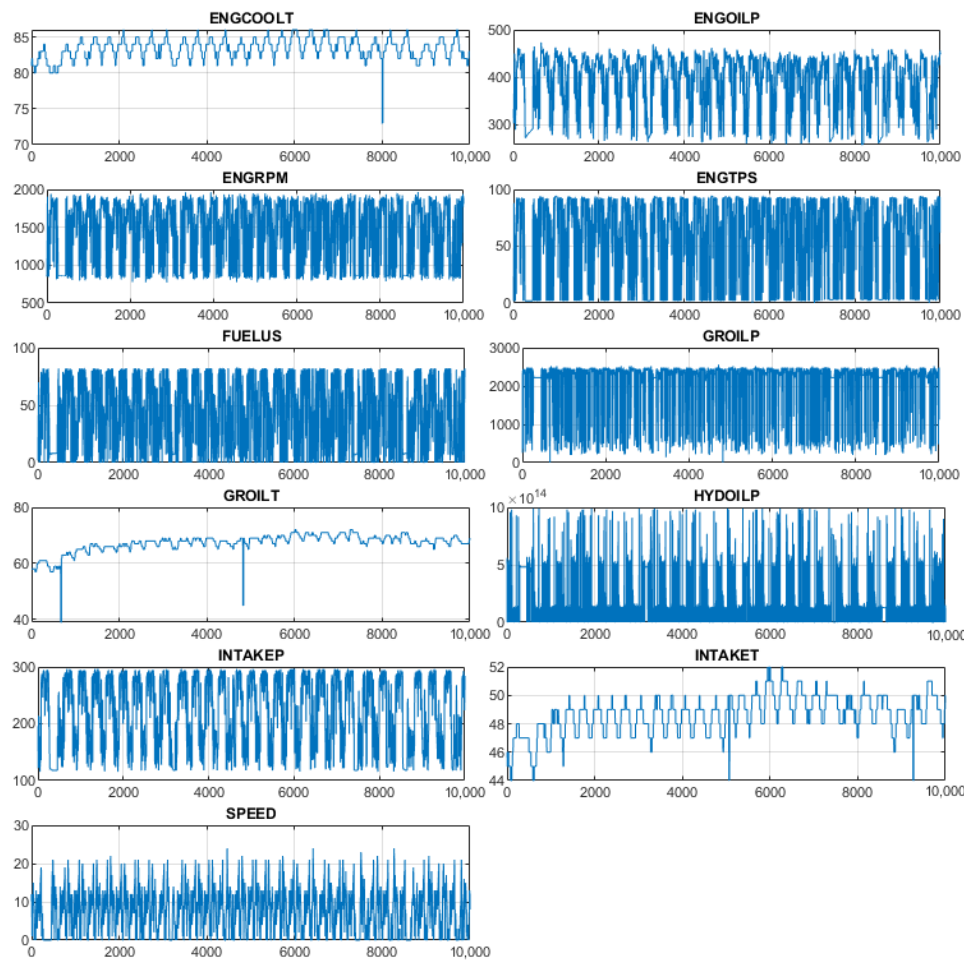
Figure 6. Full set of input variables.